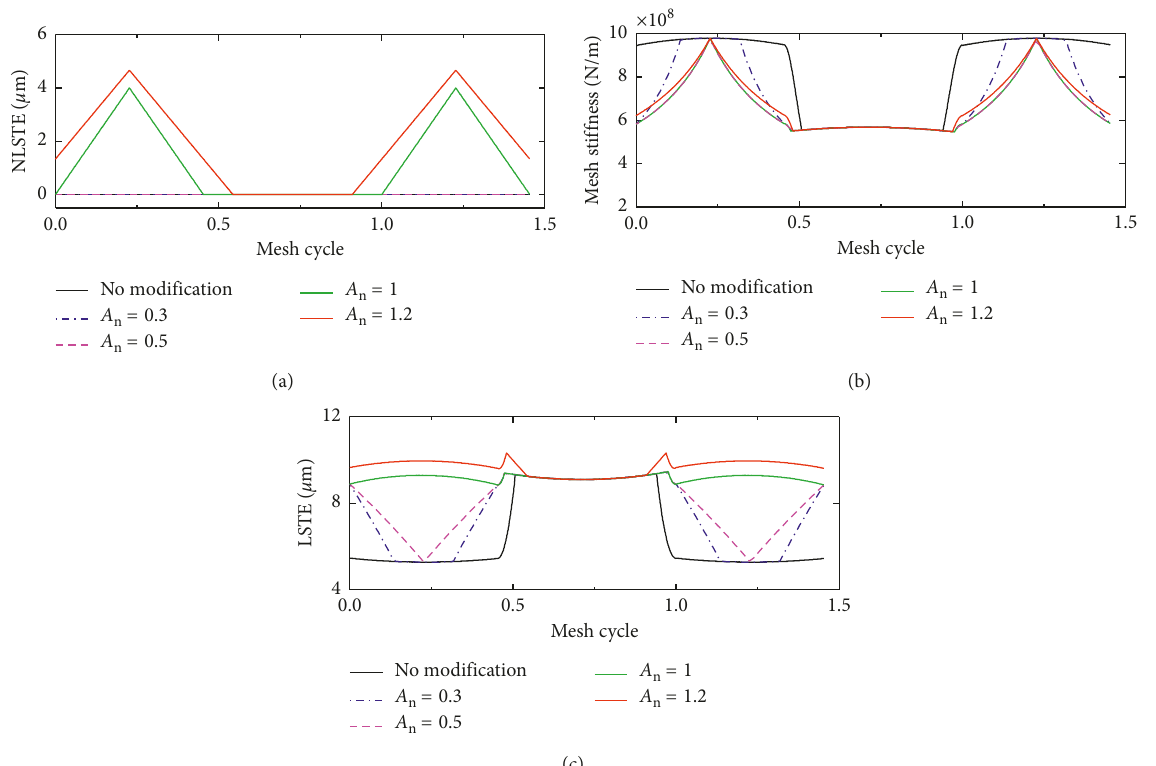
Figure 11: TVMS and TEs of a sun-planet mesh gear pair influence of the normalized modification angle: (a) NLSTE; (b) TVMS; (c)